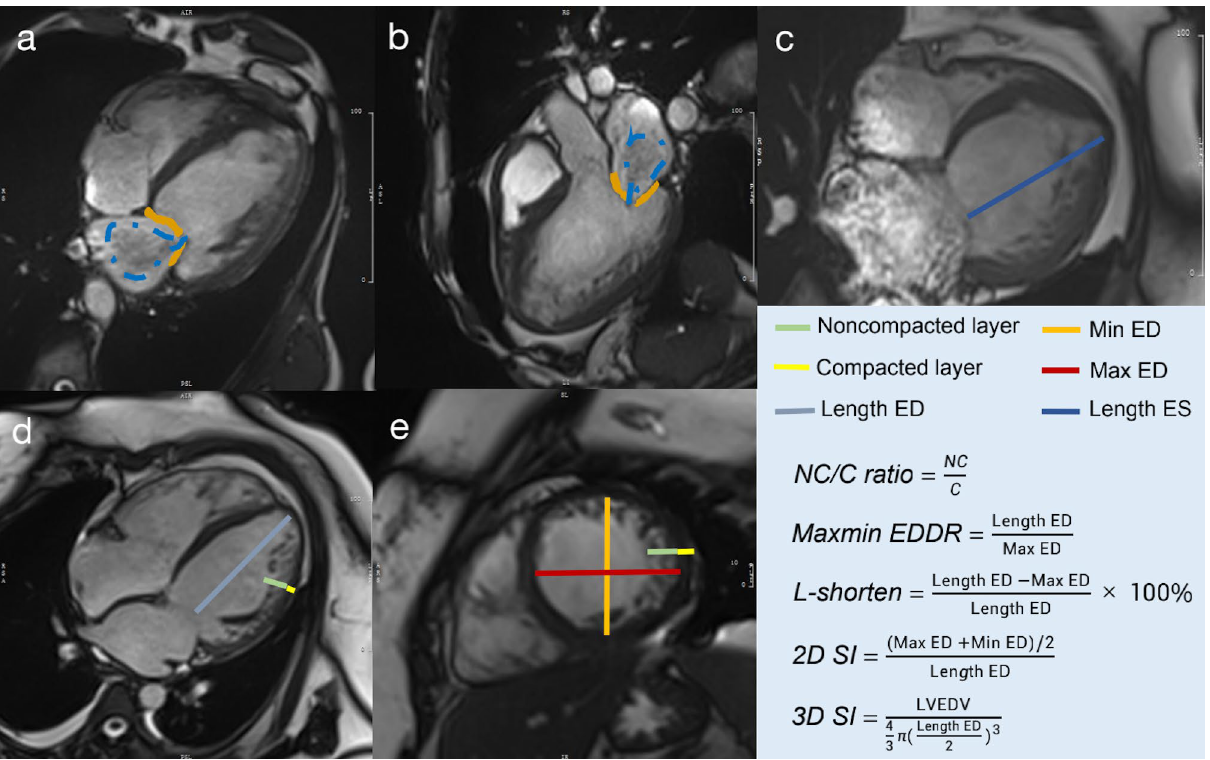
Figure 2. Representative images of mitral regurgitation and measurements of left ventricular geometry. (a,b) The yellow indicates mitral valve position, and the blue indicates blood flow through the mitral valve to the left atrium. (c–e) Measurements of left ventricular geometry in four-chamber cine at end-systole (c) , four chamber cine (d) and short axis cine (e) in end-diastole. ED end-diastole, ES end-systole, NC/C noncompaction/ compacted, MaxMin EDDR maximum/minimum end-diastolic ratio, 2D SI two-dimensional sphericity index, 3D SI three-dimensional sphericity index, LVEDV left ventricular end-diastolic